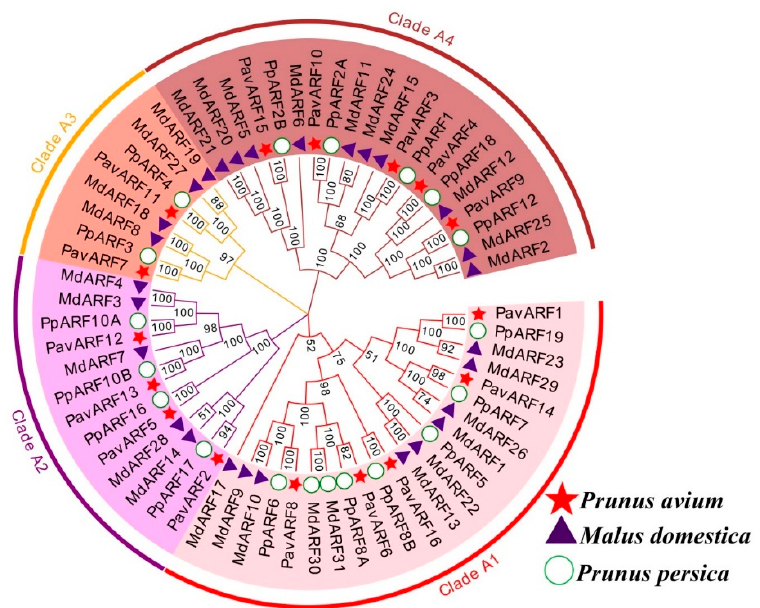
Figure 1. Phylogenetic tree of ARF proteins from sweet cherry, Malus domestica , and Prunus persica . All ARFs are divided into five clades, each signed by a different color, The PavARFs of the sweet cherry was marked red star.